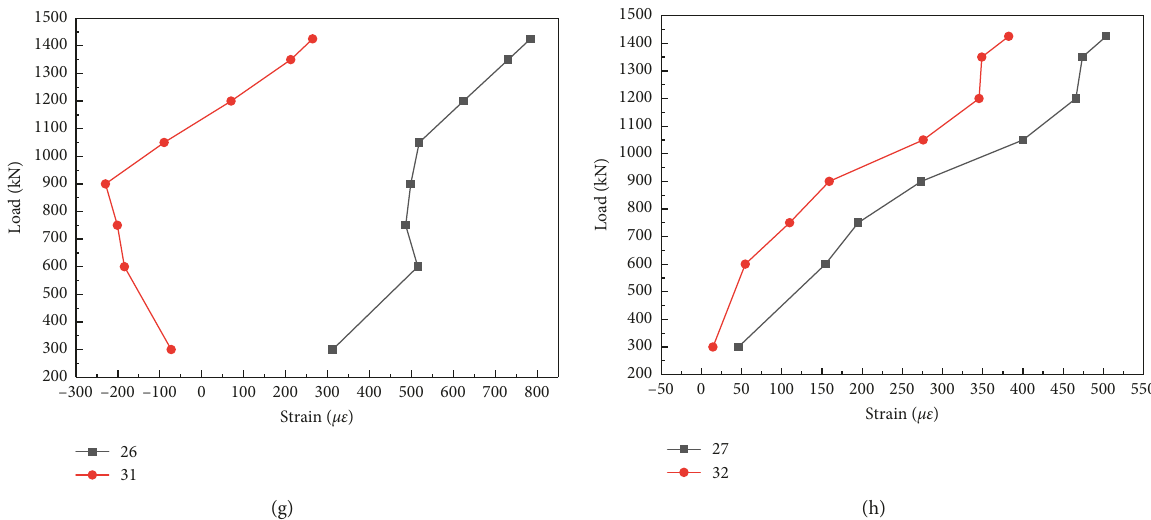
Figure 26: Load-strain curves of A-axis and C-axis horizontal rods in Models 1, 2, and 3. (a) The sidespan in Model 1. (b) The second span in Model 1. (c) The sidespan in Model 2. (d) The second span in Model 2. (e) The midspan in Model 2. (f) The sidespan in Model 3. (g) The second span in Model 3. (h) The midspan in Model 3.